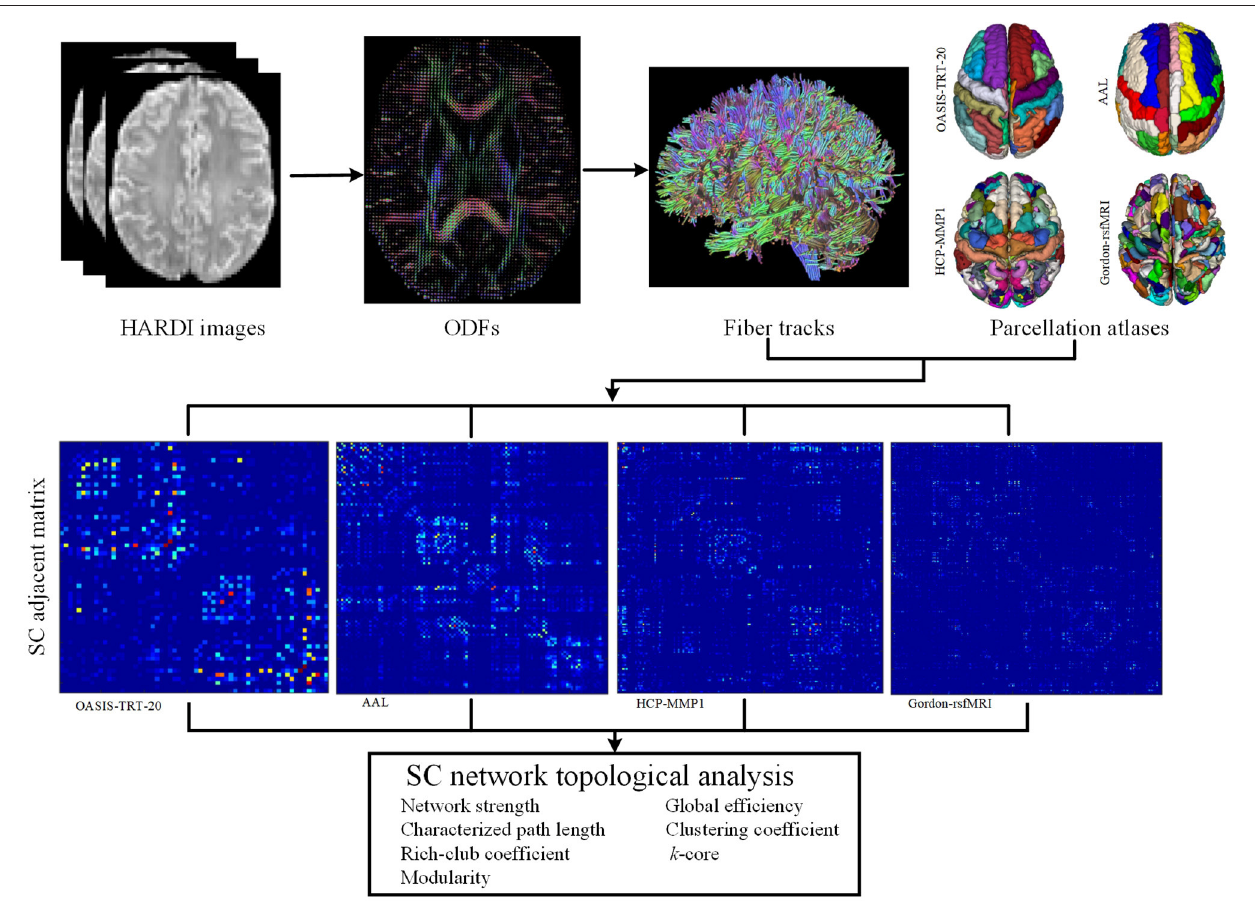
FIGURE 1 | Flowchart of SC network topological analysis. Four parcellation atlases were employed to define the nodes of the SC networks, including OASIS-TRT-20 (62 regions) (Klein and Tourville, 2012), AAL (116 regions) (Tzourio-Mazoyer et al., 2002), HCP-MMP (180 regions) (Glasser et al., 2016), and Gordon-rsfMRI (333 regions) ( Gordon et al., 2014). ODFs were computed from HARDI images with a general q-ball imaging (GQI) computational model. Whole-brain tractography was performed using the DSI-Studio tool, and edges were determined by the number of neural connections between each pair of parcellated